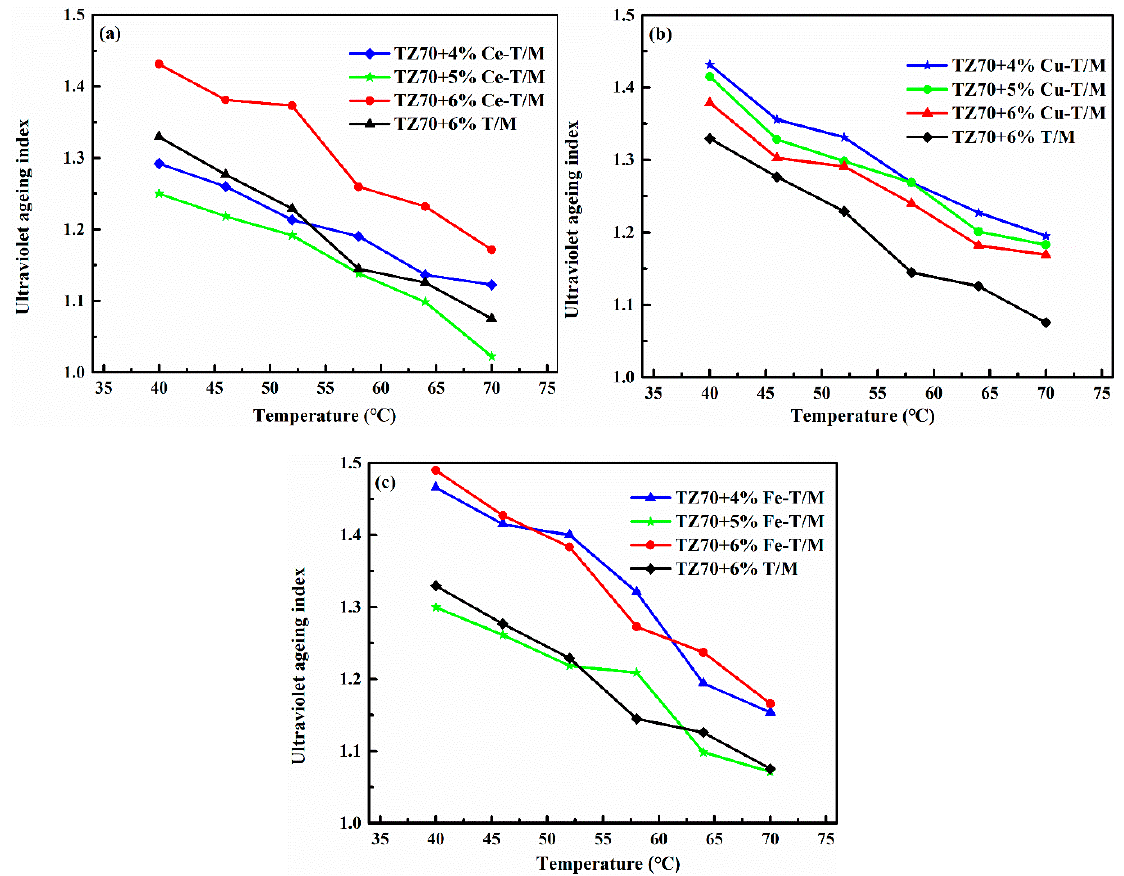
Figure 6. The AI value of ( a ) Ce-T/M, ( b ) Cu-T/M, and ( c ) Fe-T/M modified bitumen after UV